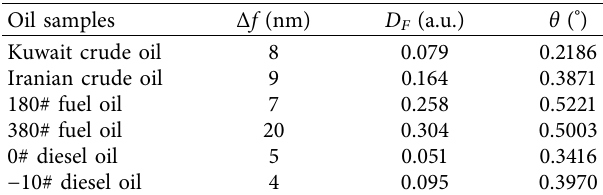
Table 3: Redshift of the main peak position ( Δ f ), fluorescence intensity distance ( D F ), and generalized included angle cosine ( θ ) determined for the experimental and composite fluorescence